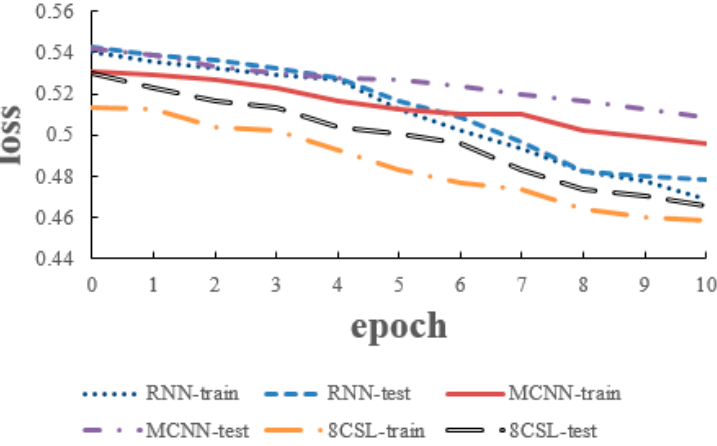
Healthcare 2020 , 8 , x 13 of 16